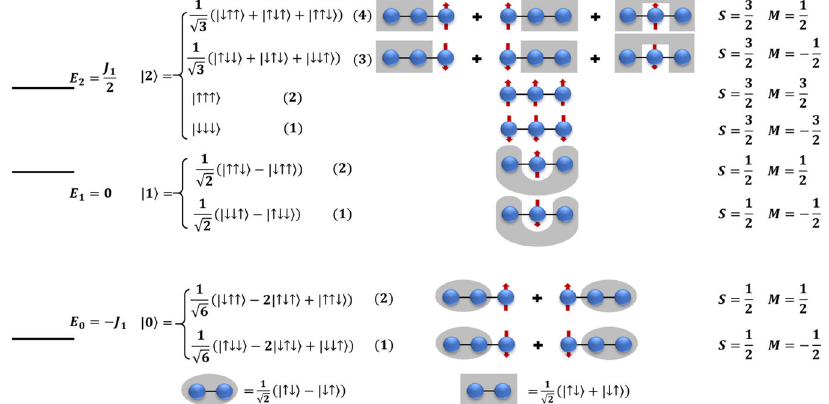
Fig. 3 The level spectrum and corresponding wave functions of one isolated trimer. The second column lists the wave functions in the spin- z basis, while the third column presents the spin structures using a basis of singlets (gray ovals and rounded shapes), zero-magnetization triplets (gray square shapes), and unpaired spins (arrows). The rightmost column lists the total spin quantum number S and magnetic quantum number M